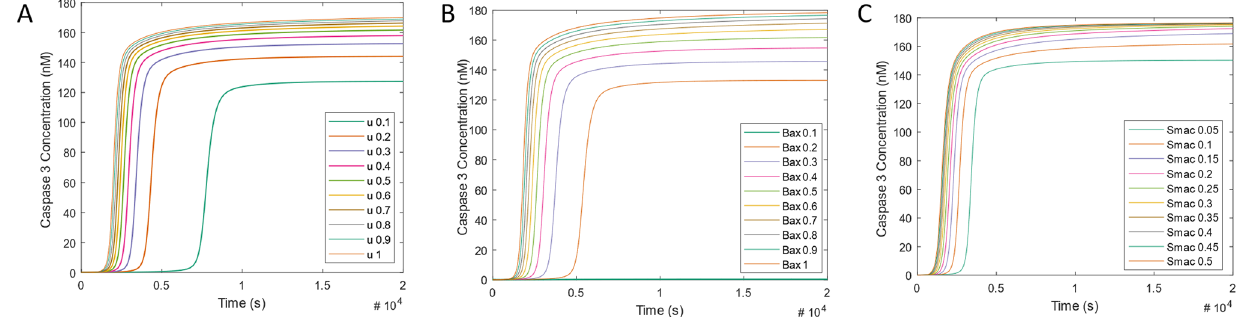
Figure 4. Impact of Input, BAX and SMAC concentration on Caspase 3 activation. Time course activation of caspase 3 upon step-like increase in ( A ). Input stimulus concentration from 0.1–1 nM, ( B ) initial BAX concentration (BAX0) from 0.1–0.9 nM and ( C ) initial SMAC release rate from 0.05–0.5 s −1 . ( A ) Illustrates caspase 3 activation upon input stimulus variation. Lower u increases the caspase 3 activation time-delay while caspase 3 is activated earlier upon increase in u . ( B ) indicates that caspase 3 simulated response time and amplitude is inversely related to initial BAX concentration (BAX0). Lowest BAX0 (0.1 nM) results in caspase 3 activation time-delay of 500 s (~ 8 min) with an amplitude of over 130a.u., whereas the highest BAX0 (0.9 nM) release rate (0.05 s −1 ) results in an increase in caspase 3 activation time-delay to a lower amplitude, whereas